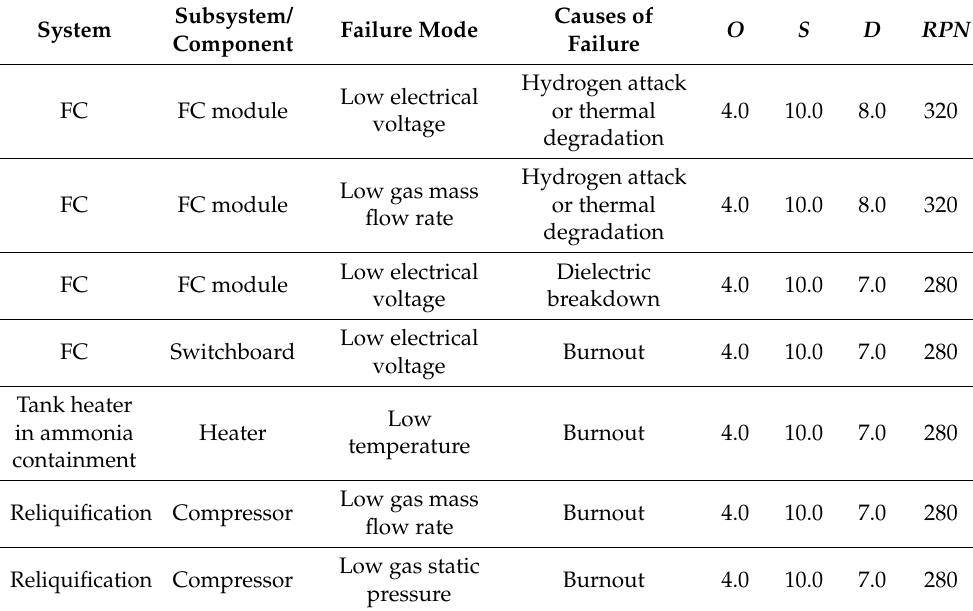
Table 3. High-criticality functional failures (occurrence ( O ), severity ( S ), and detection ( D